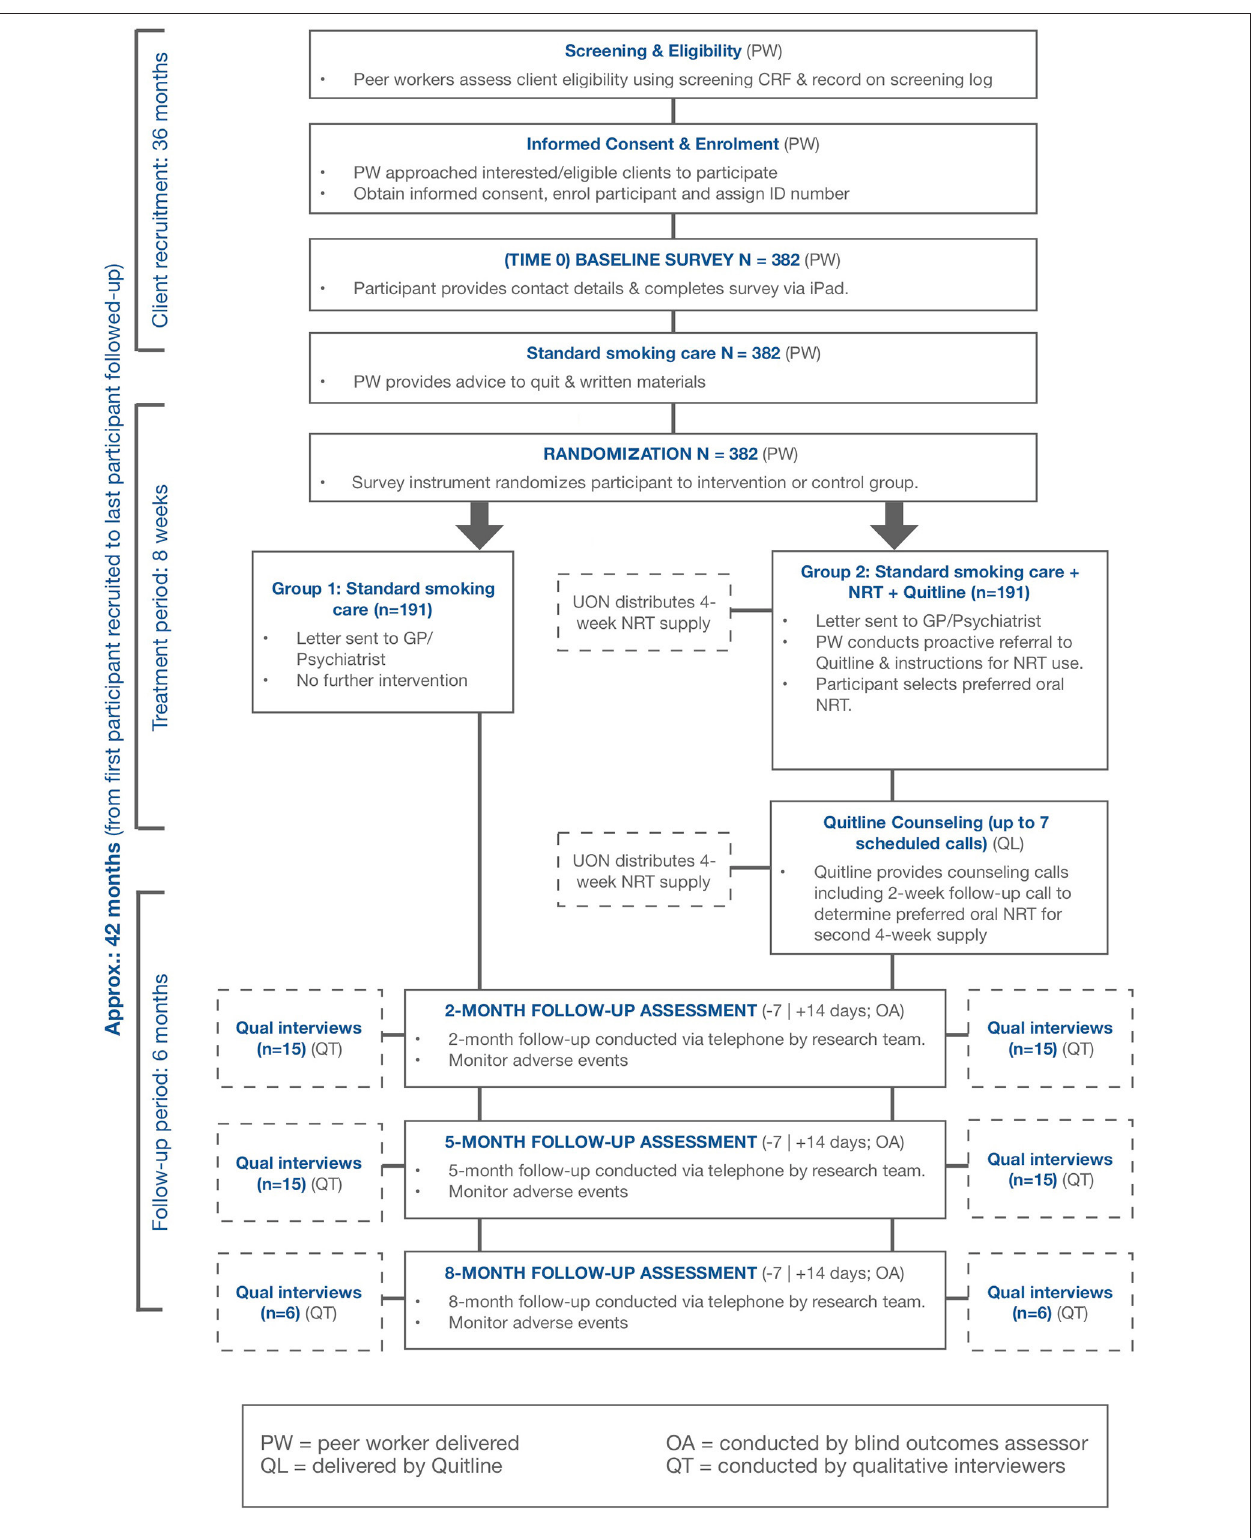
FIGURE 1 | Quitlink study